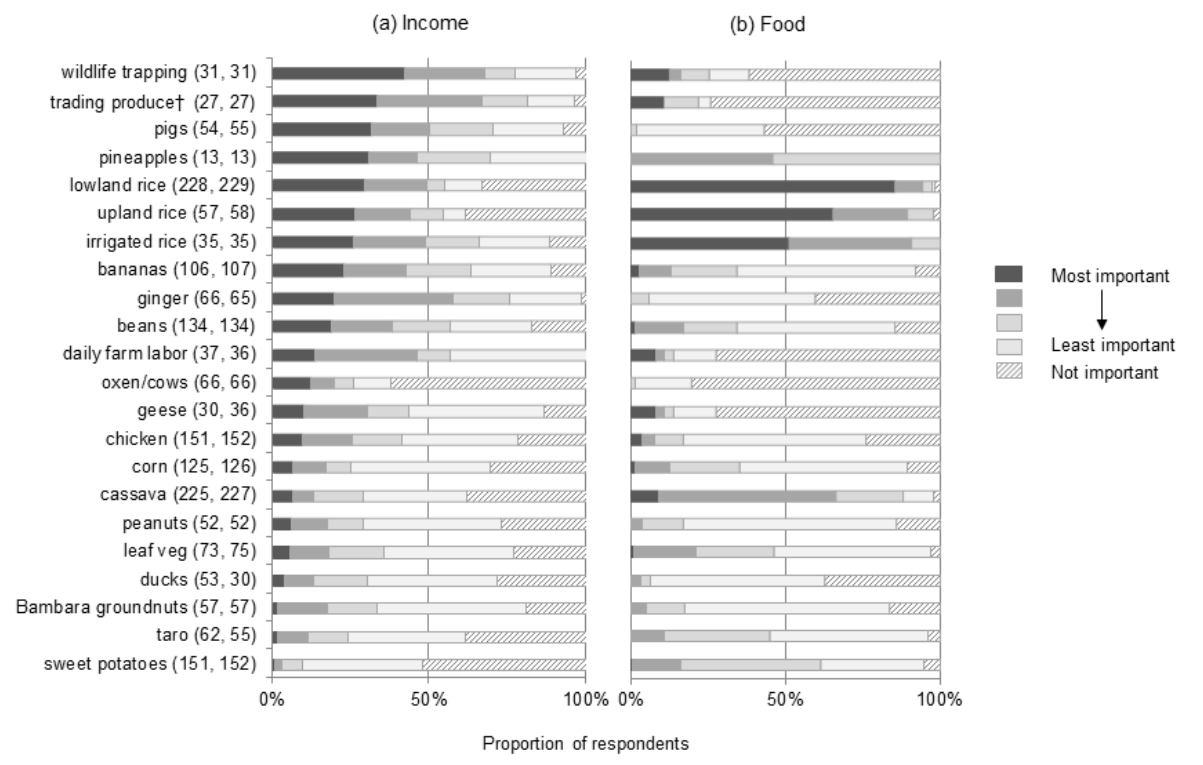
Fig. 3 . Respondents ranking of household livelihood activities in terms of importance for (a) providing income and (b) providing food. Shading indicates the proportion of respondents involved in the activity that ranked it as: 1 = most important (darkest shading); 2 = second most important (second darkest shading); 3 = third most important (third darkest shading), 4+ (lightest shading). Data are sorted by the percentage of people that ranked livelihood activities as most important for providing income. Sample sizes are provided in brackets after the name of the livelihood activity (income, food). †We were able to include an additional activity “trading produce” in the ranking exercise for which it was not possible to calculate detailed household livelihood